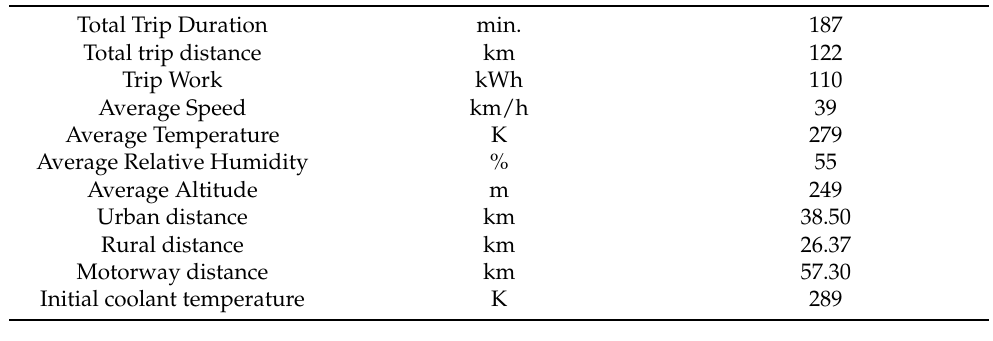
Figure 1. Measurement setup used during the tests performed on-road ( top ) and at VELA7 ( bottom ).